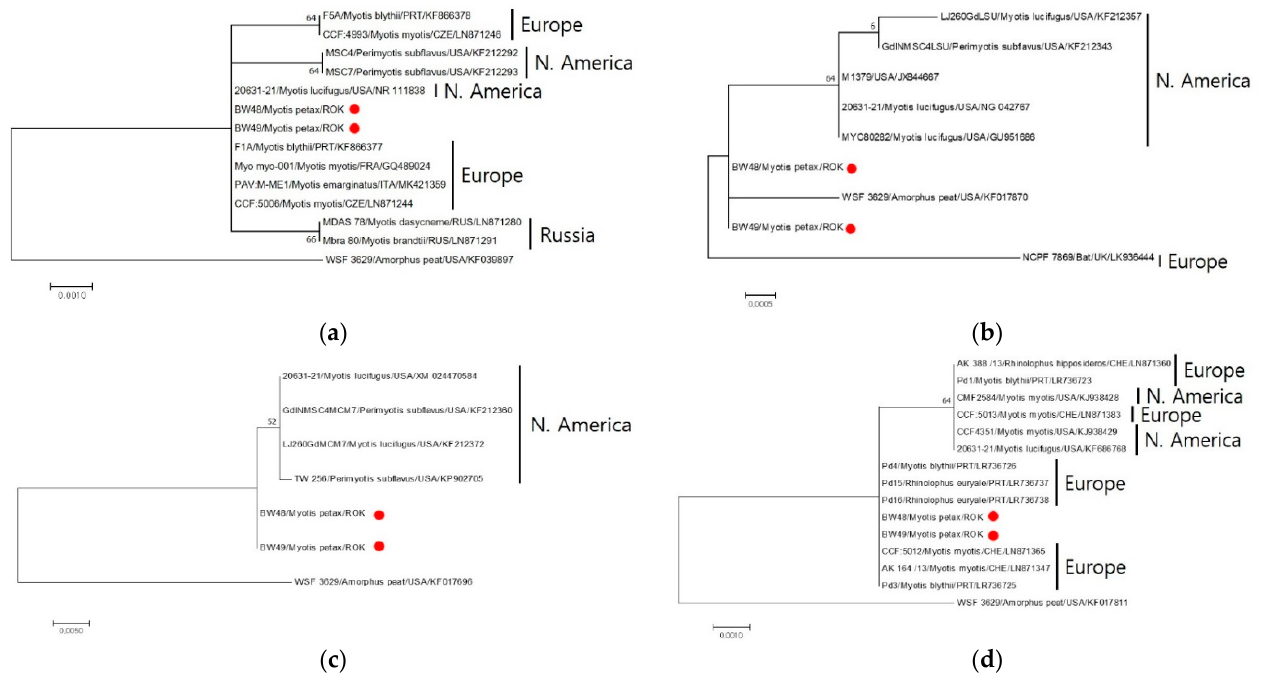
Figure 3. Maximum likelihood tree based on the DNA sequences of four loci. Comparative analysis of Pseudogymnoascus destructans ( Pd ) was based on separate analyses of four loci: ITS ( a ), LSU ( b ), MCM7 ( c ), and TEF1-a ( d ). The tree was built using MEGA 7.0.26 [16] with the best fit model. Branch support values were obtained using 1000 bootstrap replicates.